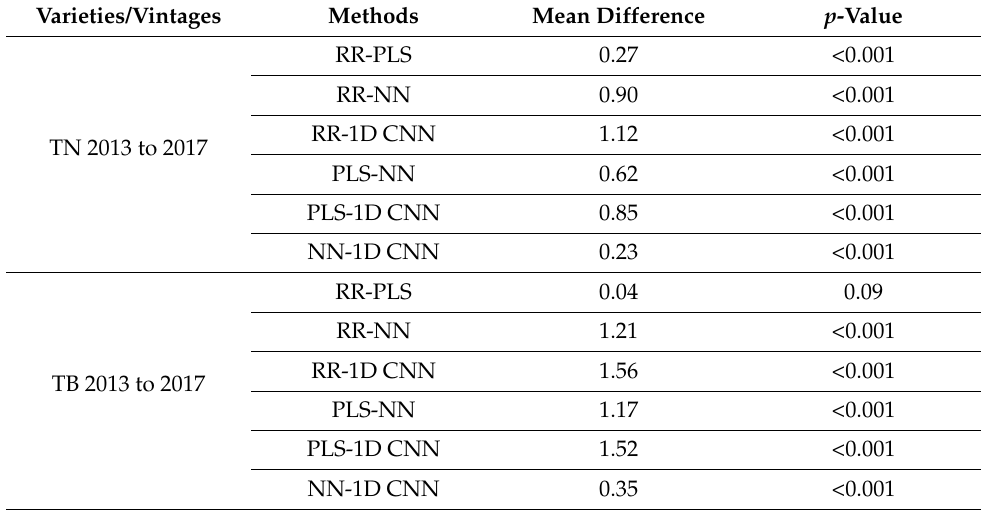
Table 7. Paired t -test to evaluate differences between the absolute errors of predictions for each pair of methods, regarding the model’s generalization ability ( α = 0.05).